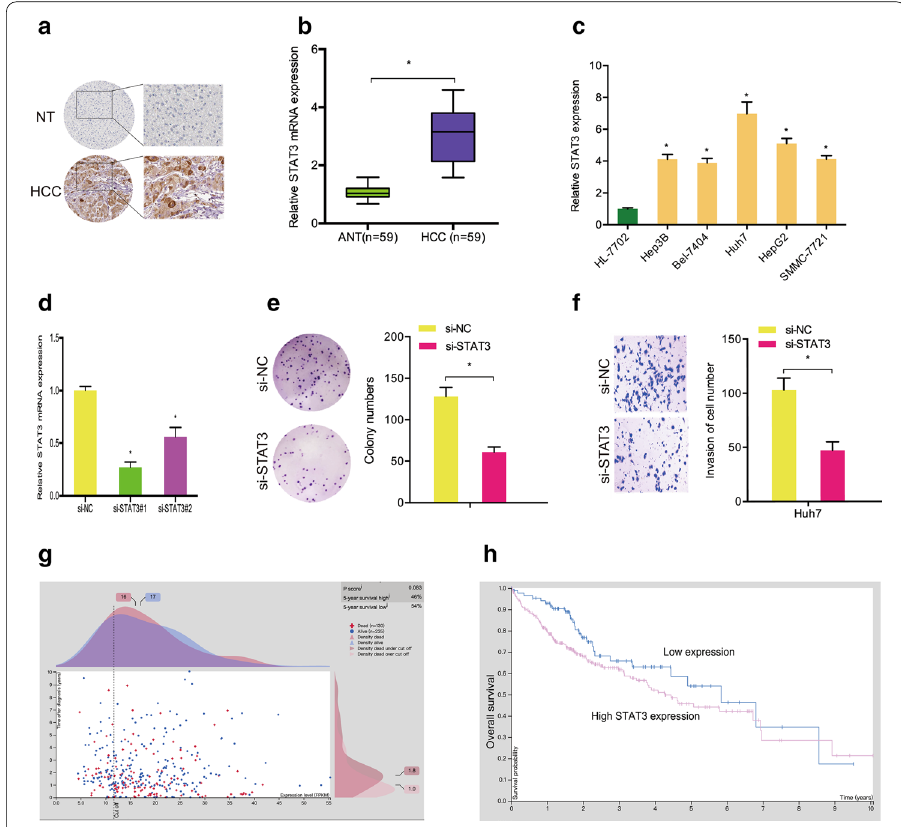
Fig. 5 Function of STAT3 in hepatocellular carcinoma. a STAT3 in hepatocellular carcinoma was evaluated by IHC. b STAT3 in hepatocellular carcinoma tissue was explored by qRT‑PCR. c STAT3 in hepatocellular carcinoma cell lines. d Transfection efficiency of si‑STAT3 in Huh7 cells. e , f STAT3 inhibition reduced Huh7 cell proliferation and invasion abilities. g , h High STAT3 levels were correlated with poor prognosis in hepatocellular carcinoma patients. * p < 0.05